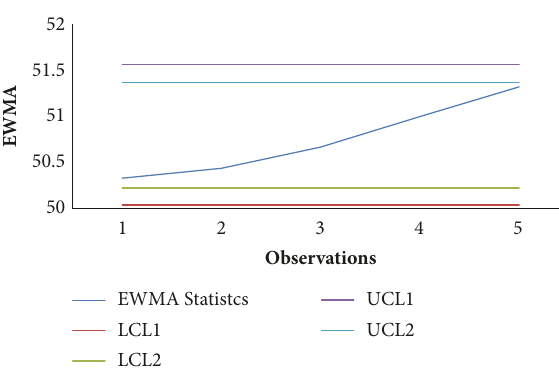
Figure 19: Proposed repetitive EWMA-RSS control chartfor Indus- trial